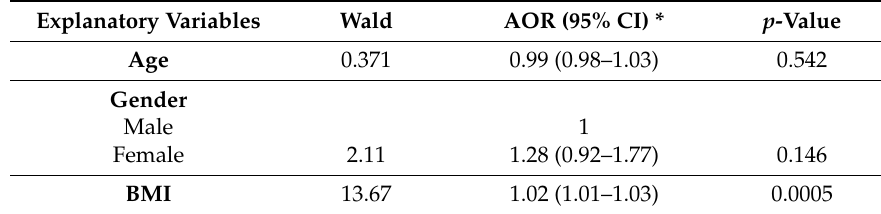
Table 2. Adjusted model for the association of BMI with